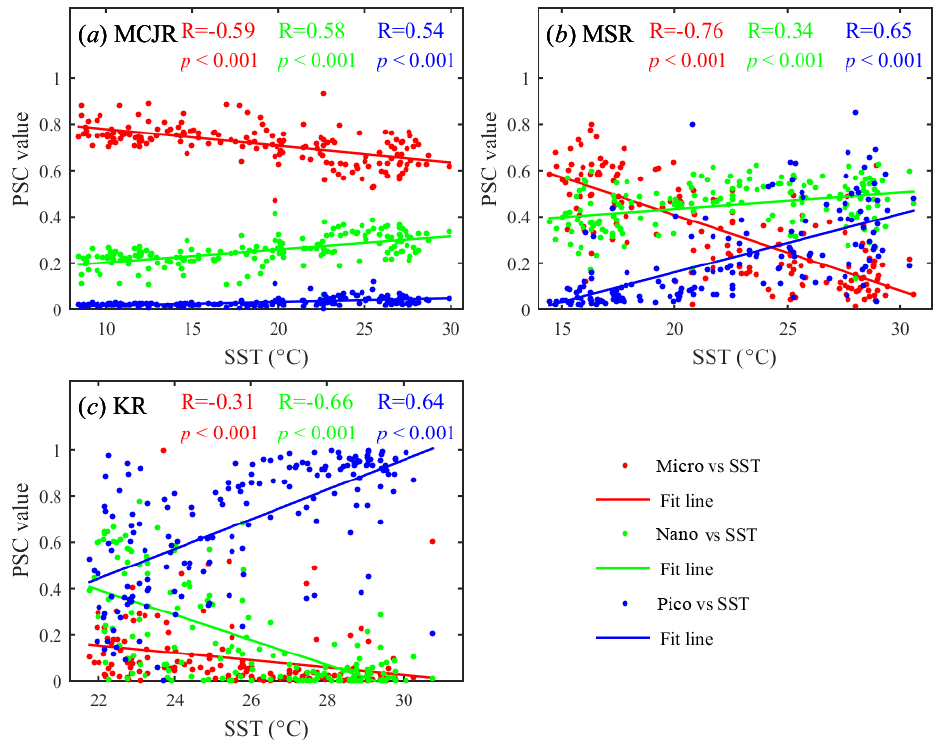
Figure 10. The scatterplots showing the relationships between the monthly phytoplankton size fractions and SST from 2003 to 2016 for the MCJR (a) , MSR (b) , and KR (c)